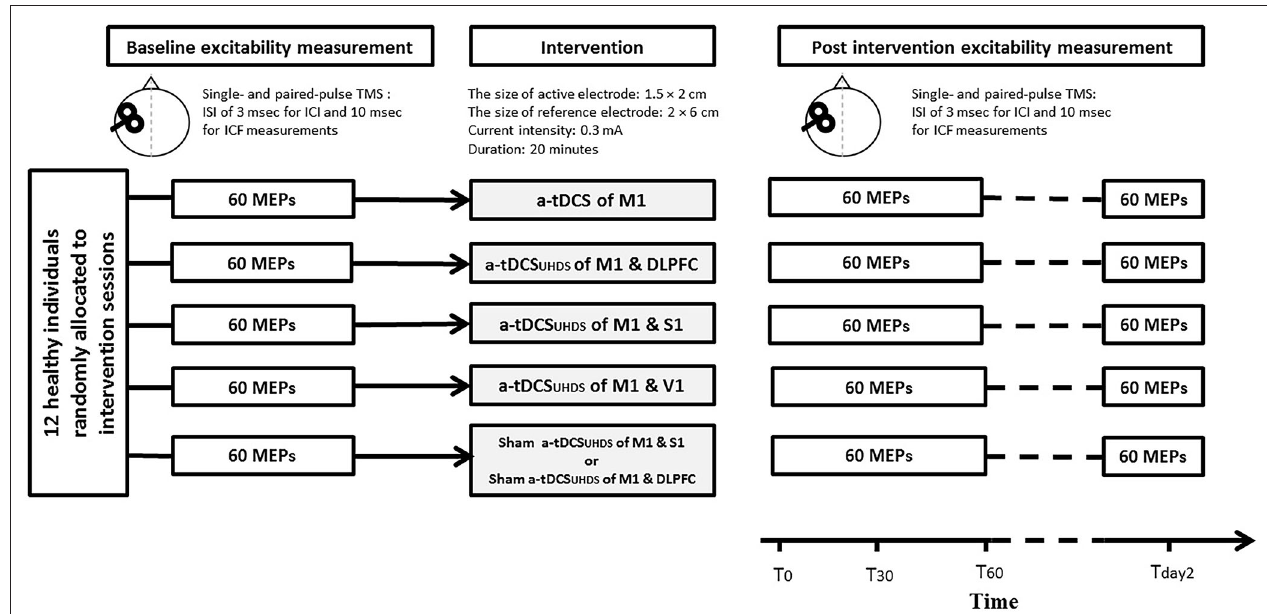
FIGURE 2 | Experimental design for the comparison of conventional a-tDCS and a-tDCS UHCDS ; in each time point of measurement, 20 single pulse transcranial magnetic stimulation (TMS), 20 paired pulse TMS with inter-stimulus interval (ISI)s of 3 ms, and 20 paired-pulse TMS with ISIs of 10